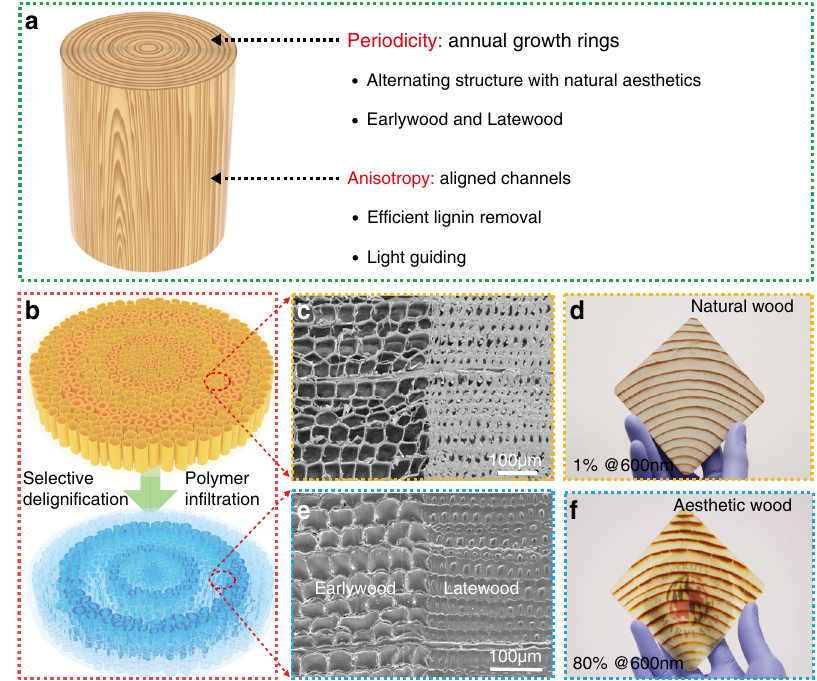
Fig. 1 Fabrication, microstructure and appearance of aesthetic wood. a An indication of the design which combines the periodicity (annual growth rings) with anisotropy (aligned channels) of wood to realize a new kind of transparent wood composite. b Schematic to display the procedures for fabricating aesthetic wood (aesthetic wood-R) from natural wood with vertically aligned cells and annual growth rings after fast spatially selective deligni fi cation and polymer in fi ltration. c , e The cross-sectional SEM images of natural wood and dense aesthetic wood-R microstructures after polymer fi lling (there is a sharp boundary between EW and LW). d , f Photos to show a large piece of aesthetic wood-R (86 mm × 86 mm × 2 mm) with preserved wood patterns and high average transparency (80% at 600 nm) derived from Douglas fi